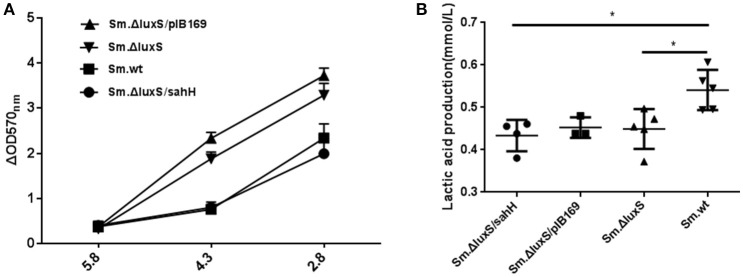
Acid tolerance and lactic acid production of four bacterial strains in the presence of biofilms. (A) Acid tolerance of four bacterial strains. ΔOD570 nm is the difference in optical density at 570 nm between the experimental groups (pH 4.3 or pH 2.8) and reflects the acid-inhibition effect. The results are shown as mean ± SEM. (B) Variability in acid production in biofilms from the four strains. Lactic acid production was higher in the Sm.wt strain than in Sm.ΔluxS and Sm.ΔluxS/sahH strains. *Significant differences at P < 0.05.